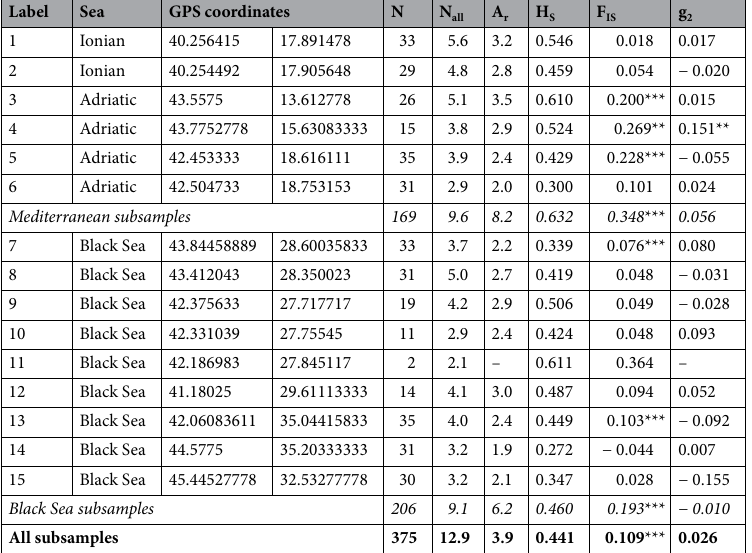
inbred individuals were present in this subsample. Selfing rate was estimated within each subsample and did not differ significantly from zero ( p -values > 0.1 after Benjamini and Yekutieli adjustment). Strong genetic structure at large spatial scale. High and significant genetic differentiation was observed among all subsamples across loci (θ = 0.375, p -value < 10 –3 , ENA corrected F ST = 0.355, IC = [0.283, 0.440]). Based on a hierarchical analysis with three levels (level 1: Mediterranean and Black Seas, level 2: Ionian, Adriatic and Black Seas, level 3: all subsamples), we observed that the three levels influenced genetic struc-